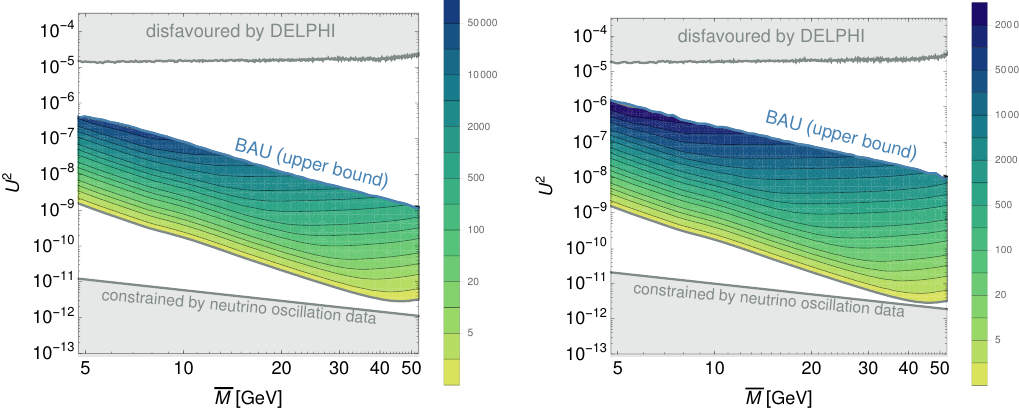
p s = 90 GeV for parameter points